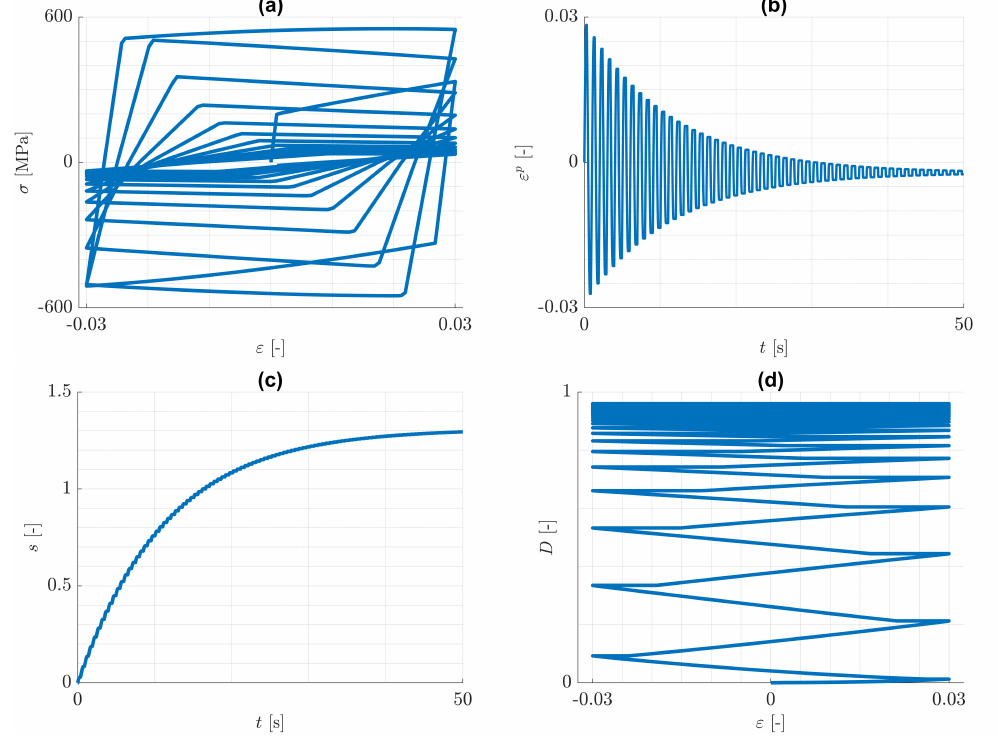
Figure 7. Pure isotropic hardening: cyclic, uniaxial tension/compression loading with ε 0 = 0,03.